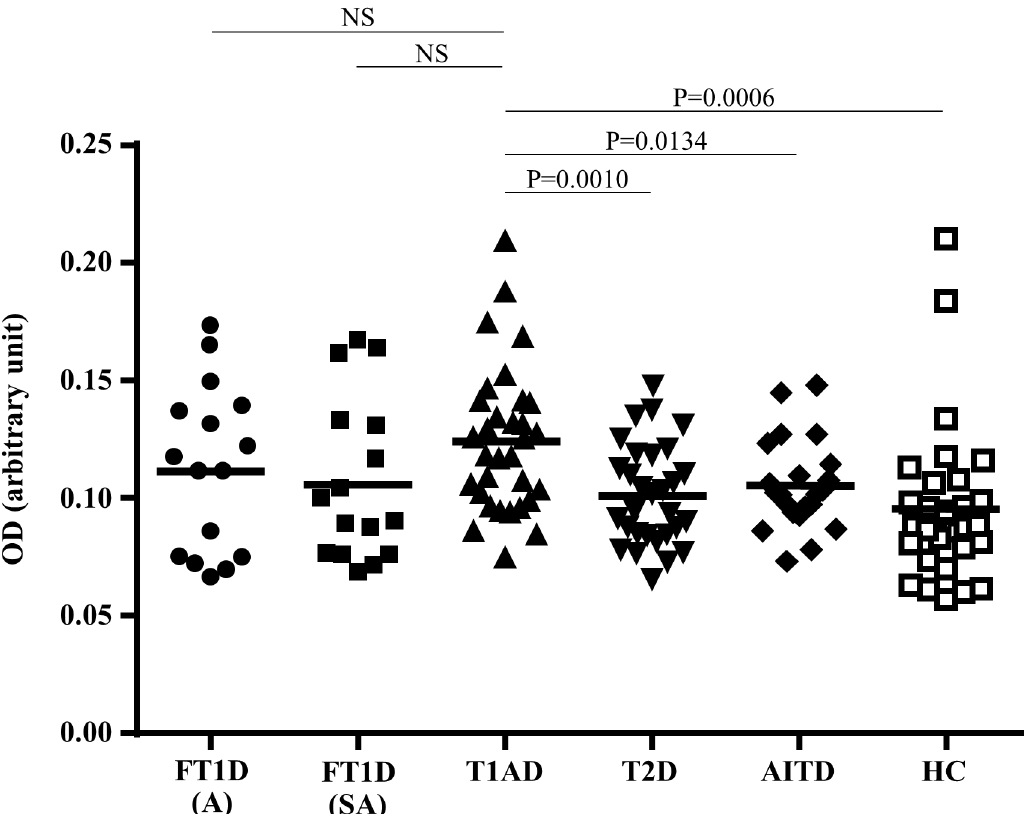
Fig 4. Titres of anti- LGALS3 antibody in sera, as determined by ELISA. Graph shows the titres of anti-LGALS3 antibody in sera from patients with fulminant type 1 diabetes in the acute phase (FT1D, A: n = 14), FT1D in the sub- acute phase (FT1D, SA: n = 14), type 1 diabetes (T1AD: n = 32), type 2 diabetes (T2D: n = 30), autoimmune thyroid disease (AITD: n = 22) and healthy control subjects (HC: n = 31). The bars indicate the